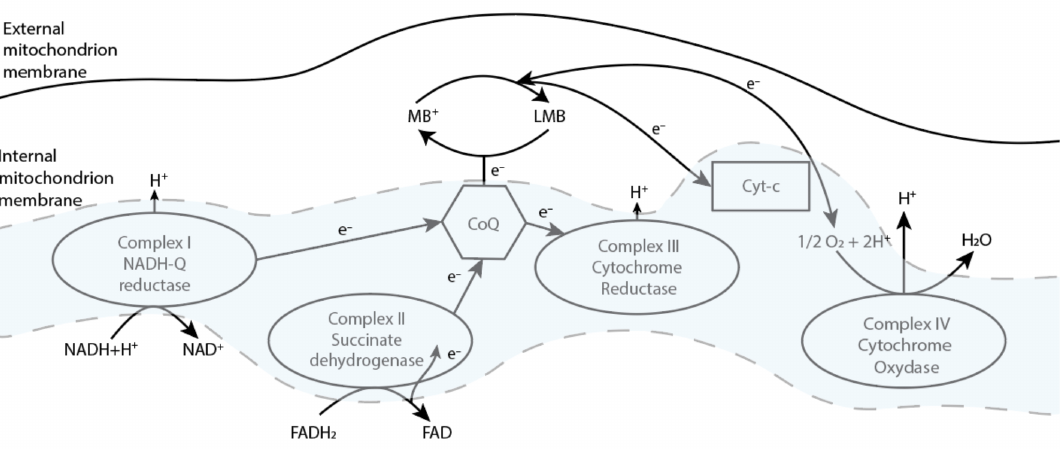
Figure 3. MB as a carrier of electrons in the electron transport chain inside the mitochondrion. MB can also influence various cell signaling pathways. According to published studies, MB inhibits the activation of inflammasomes that induce the maturation of interleukins IL-1 β and IL-18, as well as caspase-1 mediated cell death known as pyroptosis. In